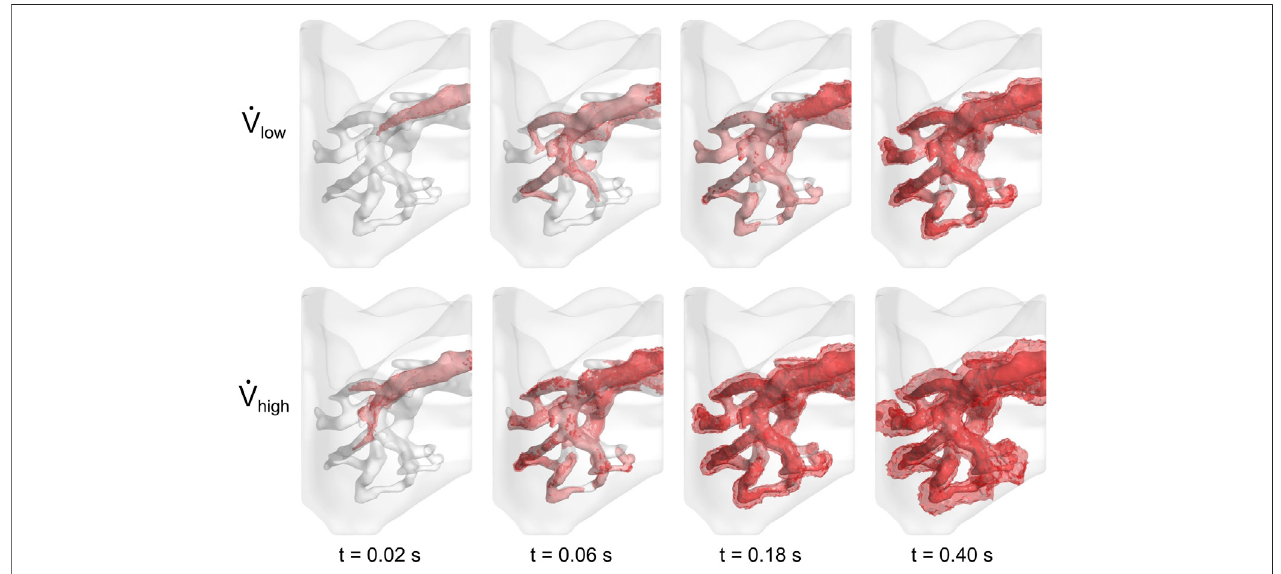
FIGURE 5 | Perfusion of cell media throughout lung vasculature. Cell media permeated through the vessel walls at 0.50 and 0.25 s for the low and high fl ow rate cases,